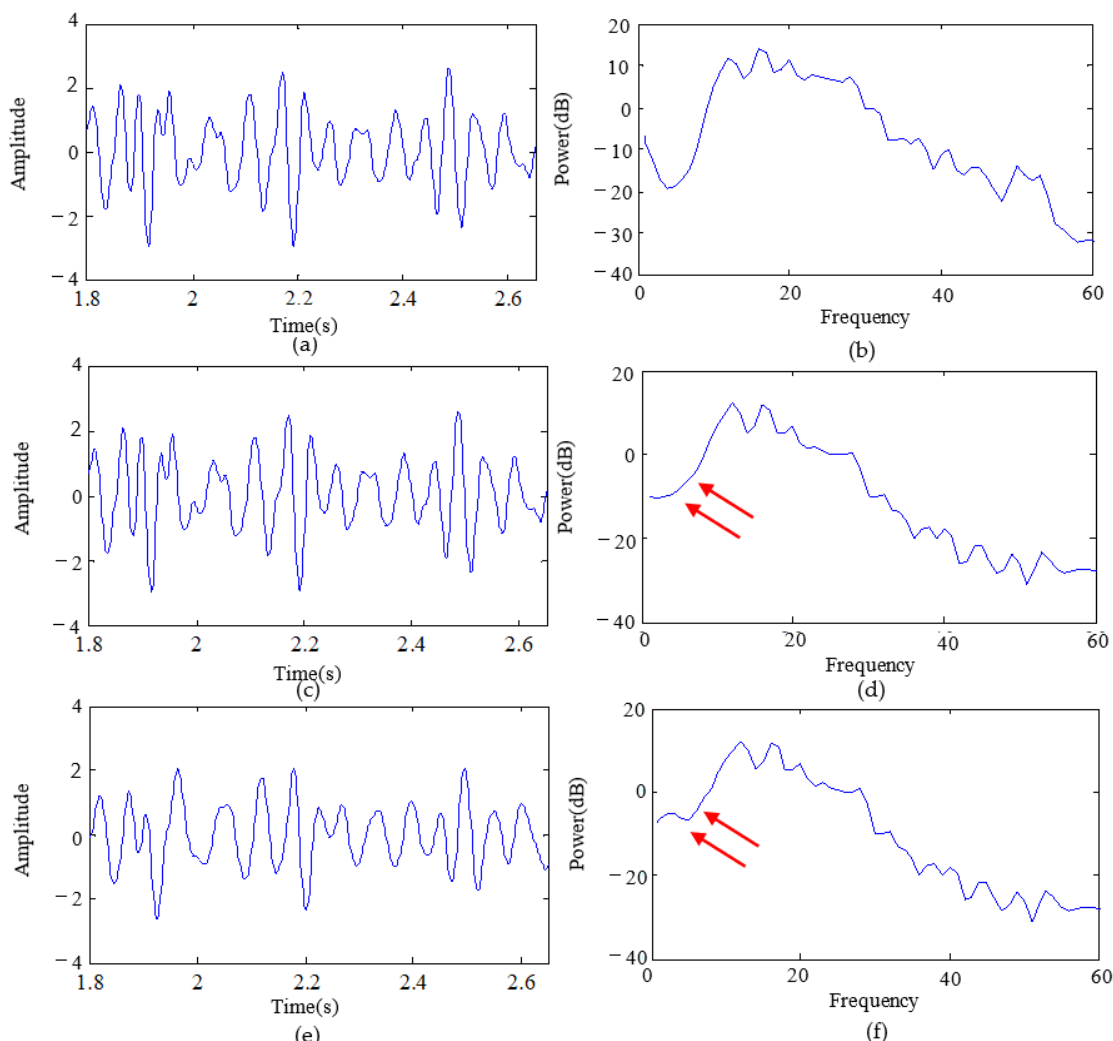
Figure 11. Comparisons of low-frequency expansion analysis for actual single trace record. ( a ) Noisy data, ( b ) frequency spectrum of original data, ( c ) data processed by CS, ( d ) frequency spectrum of ( c ), ( e ) data processed by the proposed method, ( f ) frequency spectrum of ( e ).